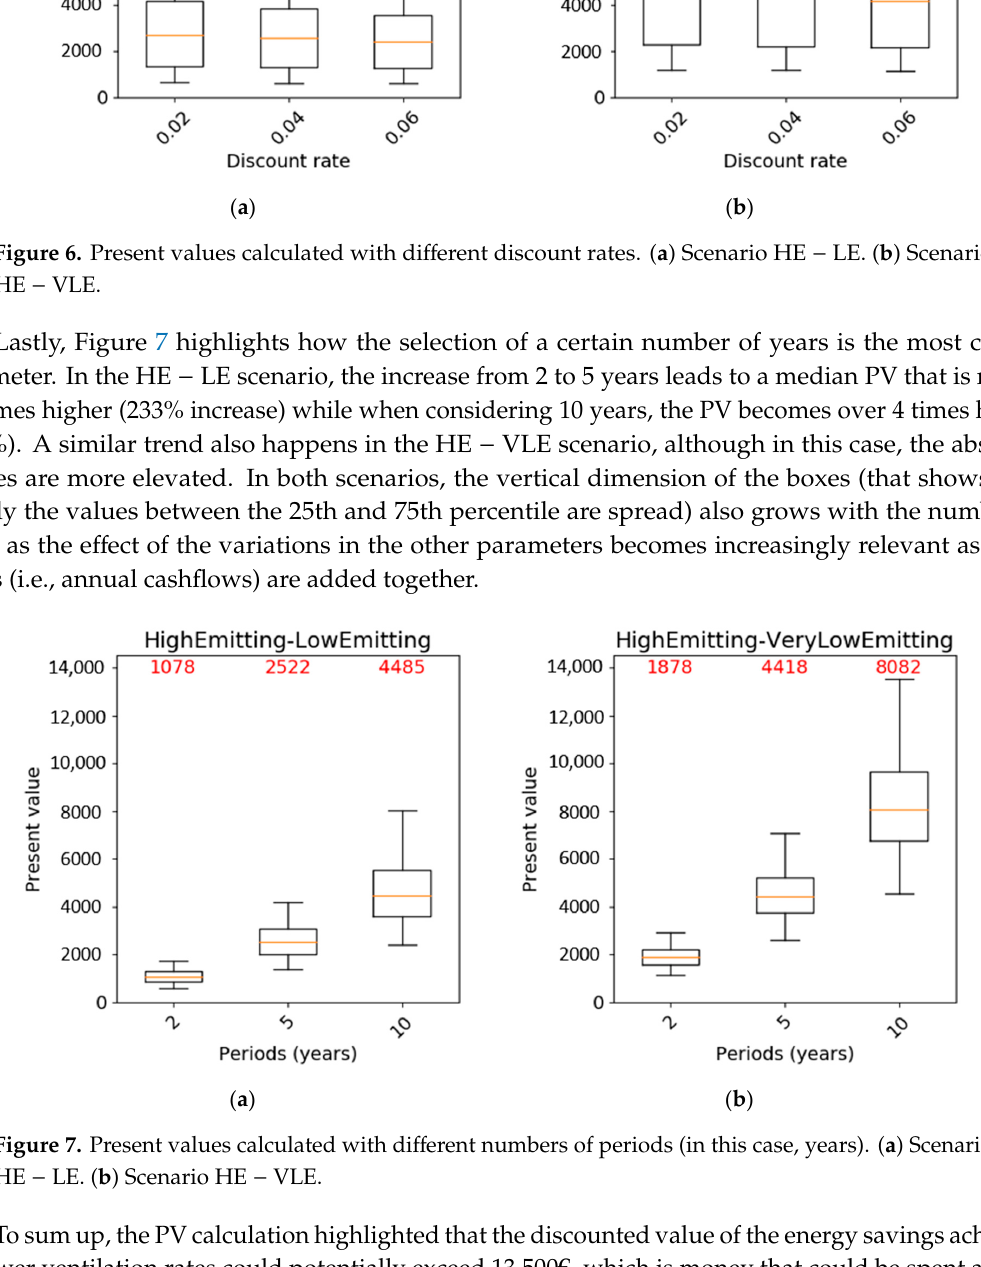
Figure 6. Present values calculated with different discount rates. ( a ) Scenario HE − LE. ( b ) Scenario HE − VLE.